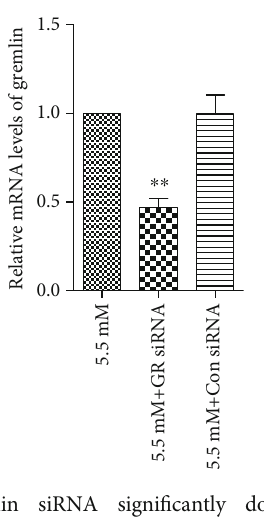
Figure 5: Gremlin siRNA signi fi cantly downregulated the expression of gremlin in RPE cells under normal glucose conditions. The cells were transfected with siRNA for 24 h and then incubated in normal glucose for an additional 24h. A real- time PCR analysis showed that the silence of gremlin signi fi cantly reduced the expression of gremlin in RPE cells. The data represent the mean ± SD of three independent experiments. ∗∗ p < 0 : 01 versus 5.5mM. GR represents gremlin; Con represents